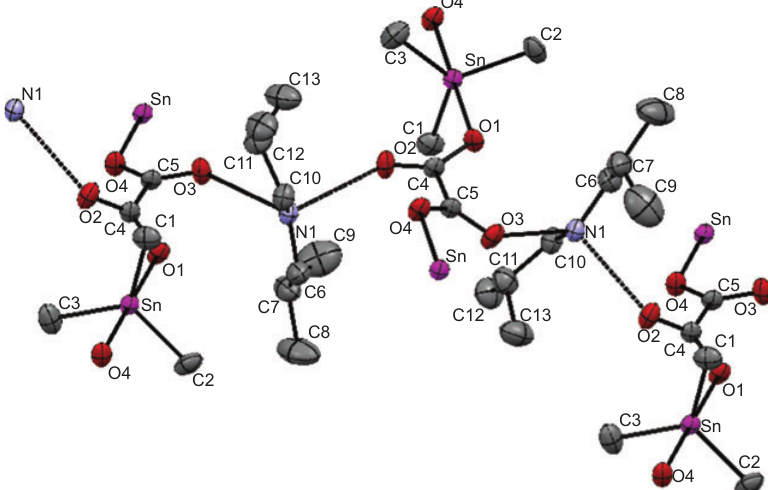
Figure 1 Two-dimensional structure of [ i -Bu Sn-O(1) 2.2815(18); Sn-O(4) # 12.2828(19); O(1)-C(4) 1.271(3) O(2)-C(4)1.237(4) O(3)-C(5) 1.235(4); O(4)-C(5)1.269(3); O(4)-Sn # 2 2.2827(19); N(1)-C(6)1.485(4). Selected bond angles: C(1)-Sn-C(2)123.84(15); C(1)-Sn-C(3)122.79(16); C(2)-Sn-C(3)113.36(17); C(1)- Sn-O(1)90.11(10) C(2)-Sn-O(1)86.47(10); C(3)-SnO(1)94.25(10); C(1)-Sn-O(4) # 1 88.93(10); C(2)-Sn-O(4) # 1 93.58(10); C(3)-Sn-O(4) # 1 86.76(10); O(1)-Sn-O(4) # 1 178.88(8); C(4)-O(1)-S 117.83(17); C(5)-O(4)-Sn # 2 118.02(18). Symmetry transformations used to generate equivalent atoms: # 1 x + 1, y , z # 2 x -1, y , z .